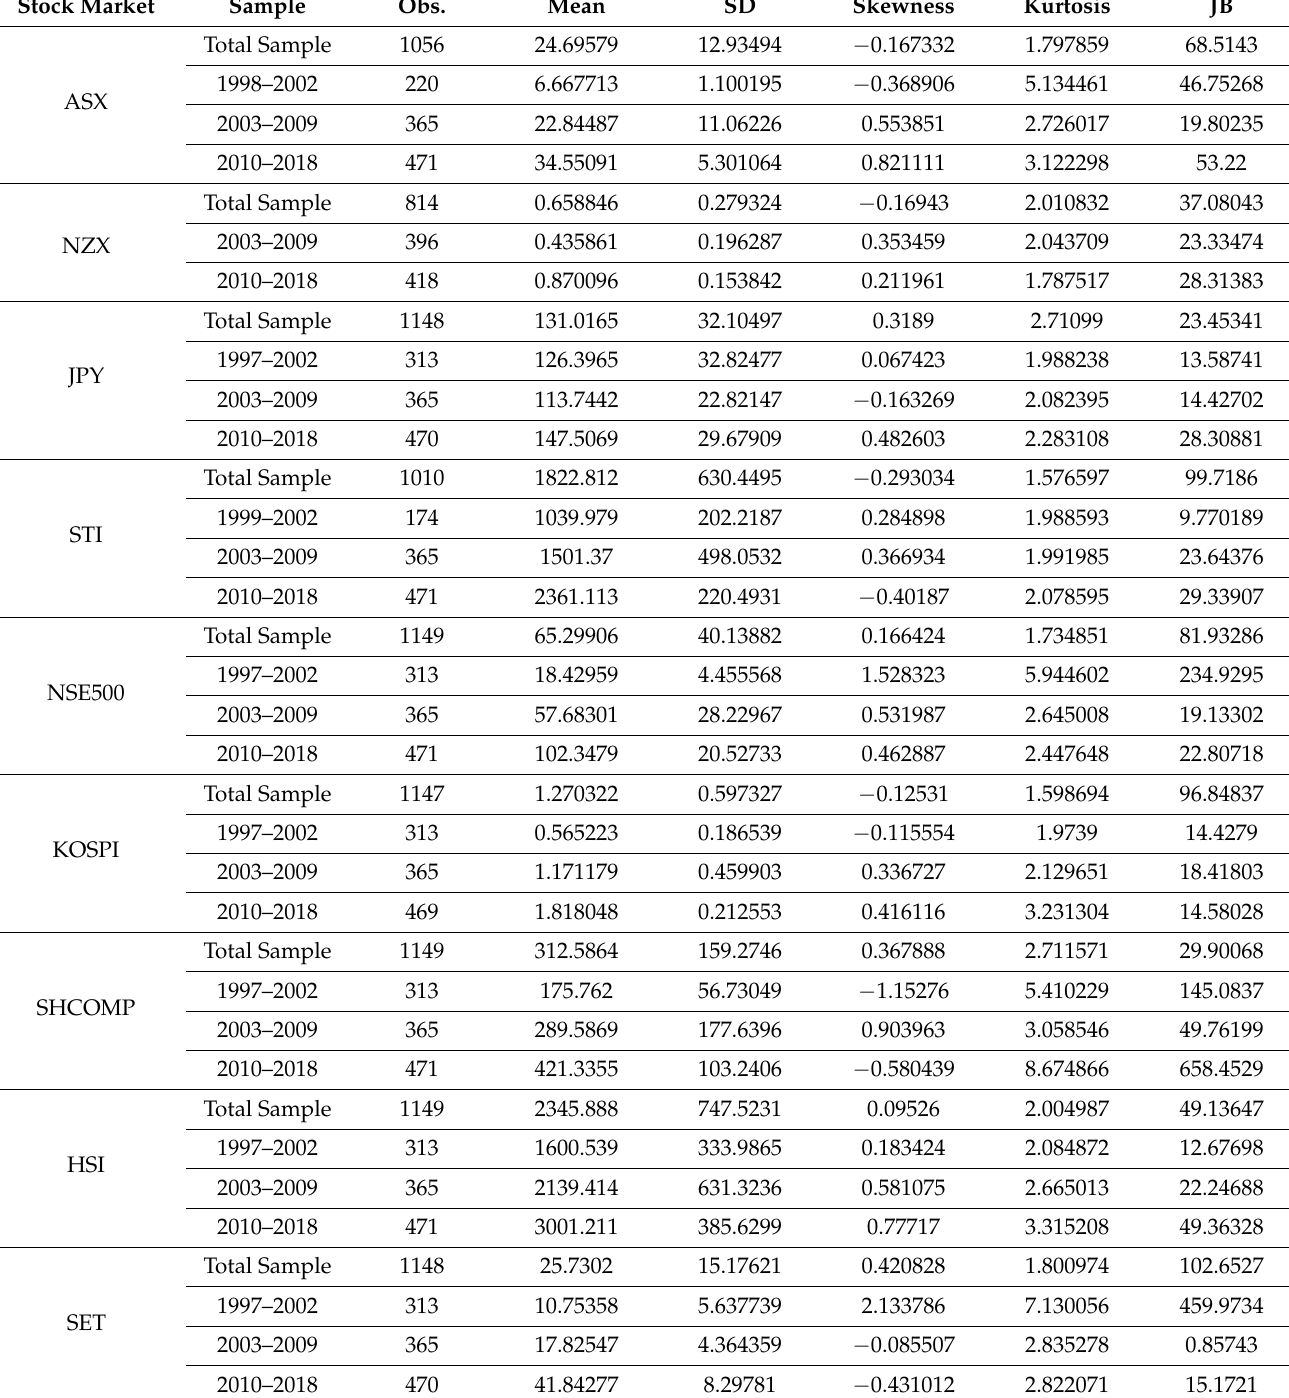
Table A1. Descriptive Statistics of 12 Asia-Pacific Countries’ Stock Market